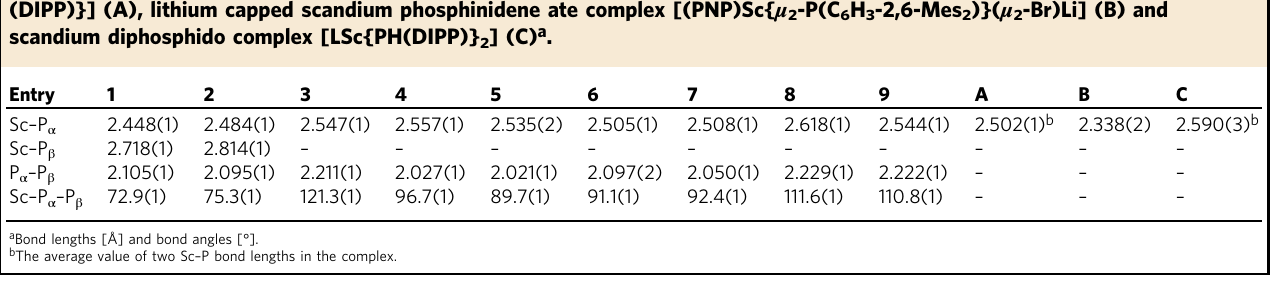
Fig. 2 Molecular structures of complexes 1 and 2 with ellipsoids at 30% probability level. DIPP isopropyl groups and hydrogen atoms were omitted for clarity. Table 1 Important bond lengths/angles of complexes 1 – 9, scandium bridged phosphinidene complex [(LSc) 2 ( µ 2 -CH 2 ){ µ 2 -P (DIPP)}] (A), lithium capped scandium phosphinidene ate complex [(PNP)Sc{ µ 2 -P(C 6 H 3 -2,6-Mes 2 )}( µ 2 -Br)Li] (B) and